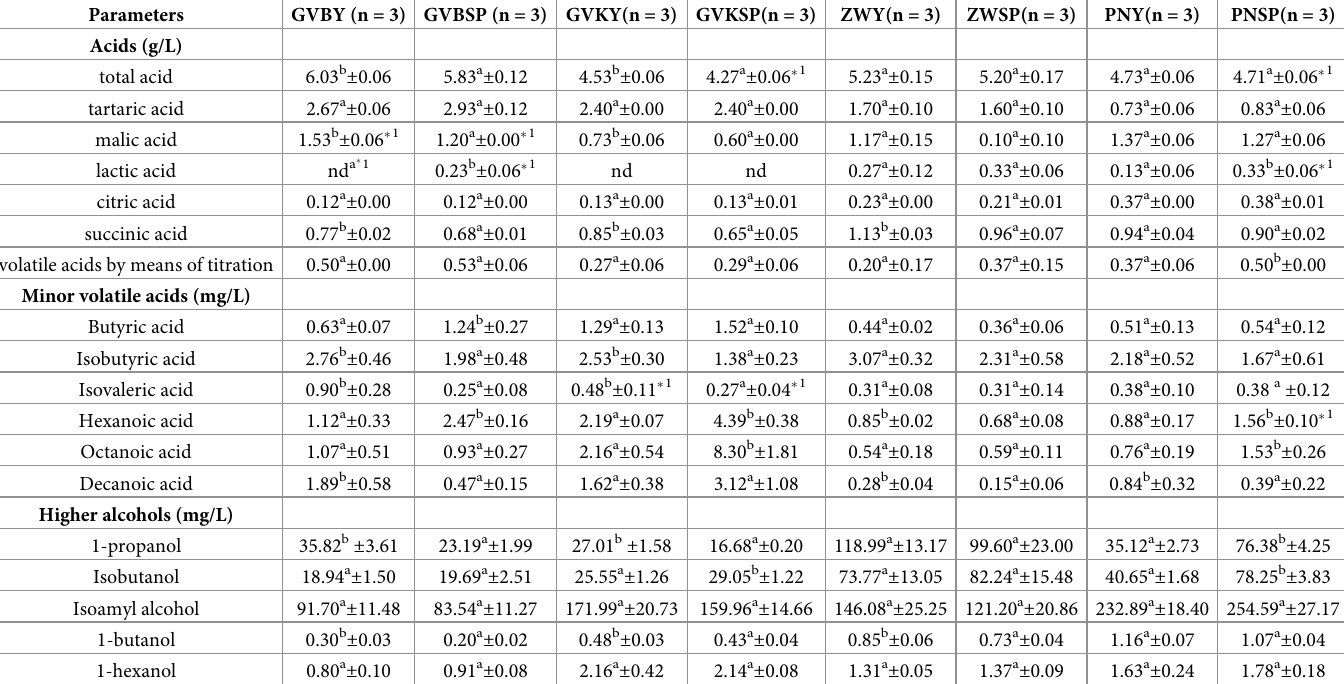
Table 2. Content of acids and higher alcohols in the wines.